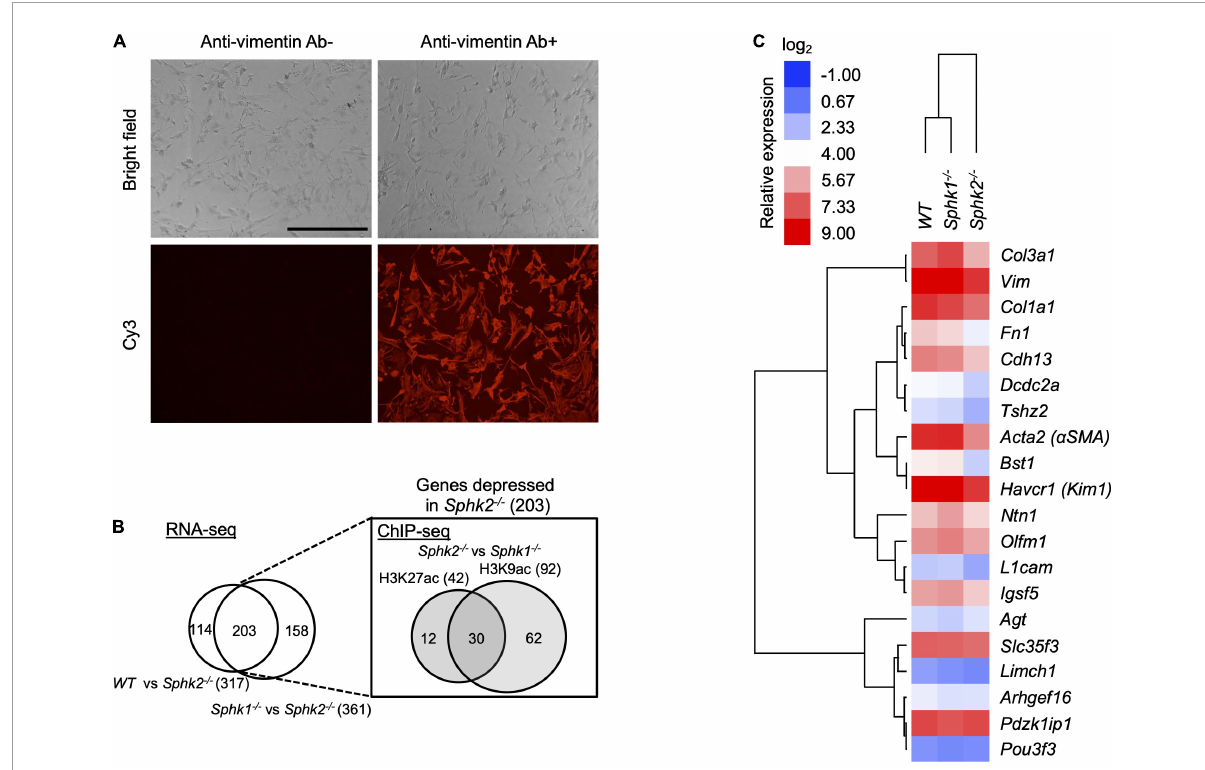
FIGURE2 Genome-wide analysis and in vivo screening identified Bst1 as a gene related with kidney fibrosis. (A) Characteristics of primary renal fibroblasts. Fibroblasts isolated from kidneys of untreated, unoperated mice, were cultured and passages 4–10 were used for all experiments. Immunocytochemistry was performed to confirm that the isolated cells were fibroblasts. An elongated, spindle-shaped morphology (phase contrast, top panels) and strong vimentin staining (red immunofluorescence, bottom panels) were observed. Anti-Vimentin Ab + : anti-vimentin, 1:250, rabbit monoclonal, ab92547, Abcam, followed by donkey anti-rabbit-Cy3, 1:500, Jackson ImmunoResearch; Anti-Vimentin Ab-: primary antibody omitted. Scale bar = 400 µ m. (B) Venn diagram based on RNA-seq and ChIP-seq of primary renal fibroblasts isolated from kidneys of untreated, unoperated WT , Sphk1 − / − and Sphk2 − / − mice. From 203 genes identified by RNA-seq that have suppressed expression in Sphk2 − / − cells (the overlap of comparison of Sphk2 − / − cells to WT and Sphk1 − / − cells, left), 30 genes that have lower histone acetylation at two sites (lysine 27 and lysine 9) on histone 3 (H3K27 and H3K9, respectively) in Sphk2 − / − cells were chosen by ChIP-seq (the overlap of comparison of Sphk1 − / − and Sphk2 − / − cells, right). (C) In vivo screening. Heat map based on expression analysis of common fibrosis-related genes and the top 50% of selected genes in panel (A) (RT-PCR of RNA isolated from kidneys after unilateral IRI). Clustering was performed based on relative gene expression. Relative expression was calculated as the ratio of gene expression in the left kidney (IRI side) compared to the right kidney (non-IRI side) of wild-type mice. n = 5–7 in panel (C) . Gene abbreviations defined in Supplementary Table 3 and Supplementary Figure 3